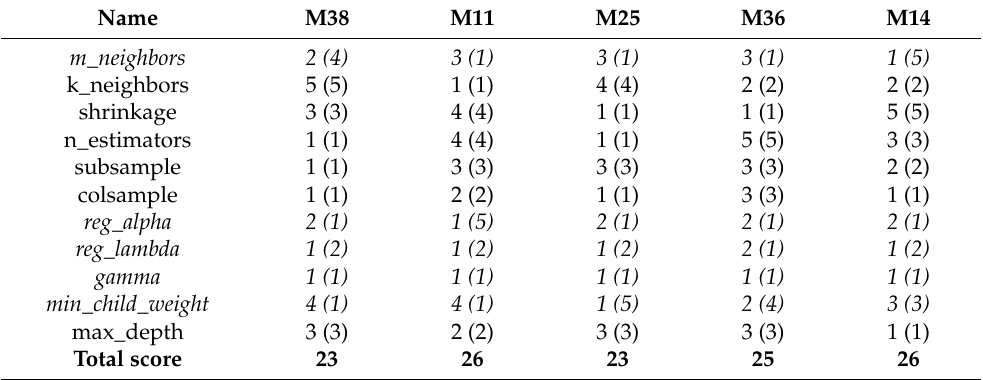
Table 7. The descending value ranking of individual hyperparameter among the top 5 performing cases, and the corresponding conservativeness ranking scores in parentheses. The parameters with normal font are those favoring smaller values for conservativeness, and those italicized favoring larger values.